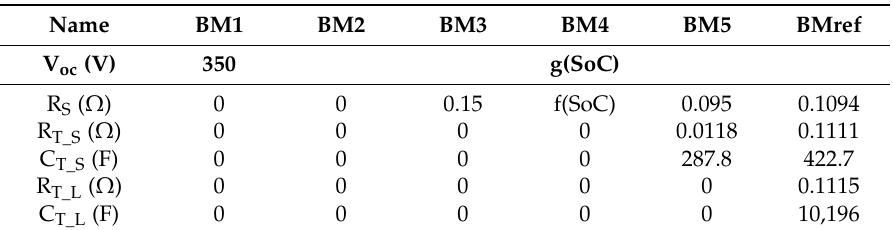
Table 3. Characteristic of battery